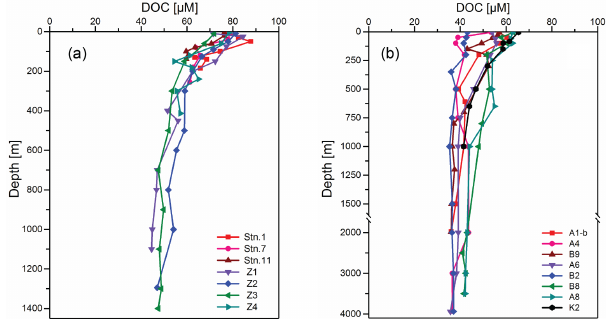
Figure 4. DOC concentrations superimposed on plots of potential temperature vs. salinity for the sampling stations in the (a) ECS and (b) Kuroshio Extension in the northwestern North Pacific. σ 0 isolines are included in the figures. Red dots indicate the potential temperature and salinity of the water types, and acronyms of water types are SMW – shelf mixed water, KW – Kuroshio Water and OW – Oyashio